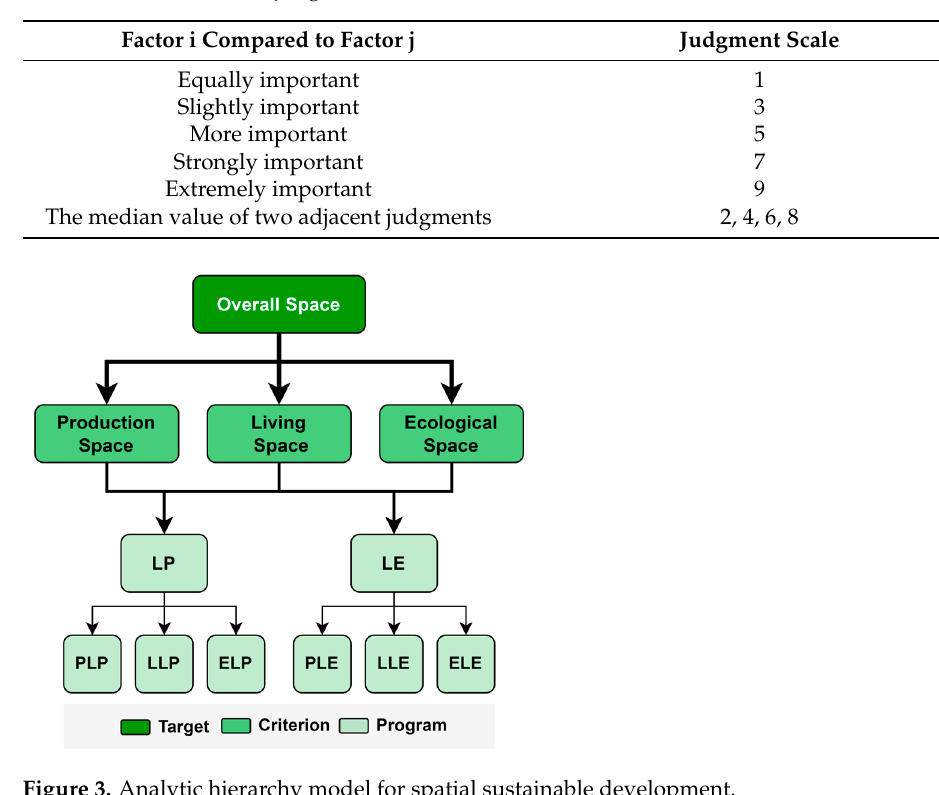
Table 2. Definition of the judgment matrix scale.